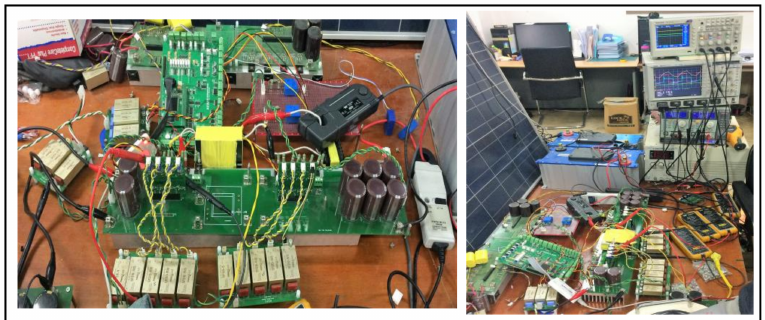
Figure 13. DAB-IBDC converter with an experimental